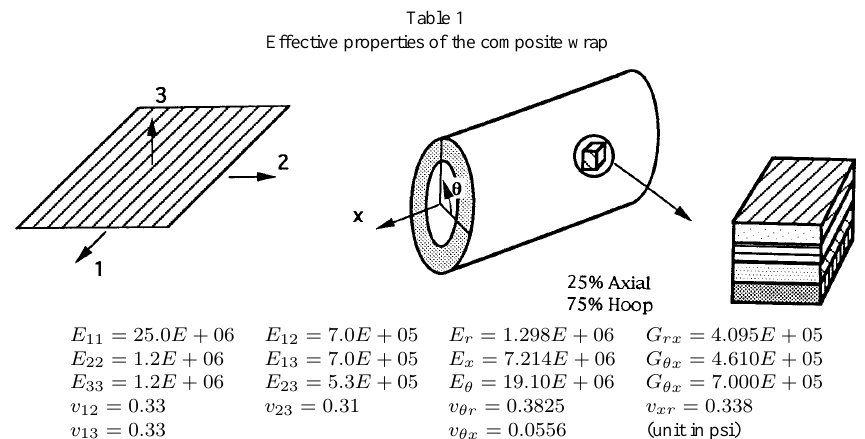
Table 1 Effective properties of the composite